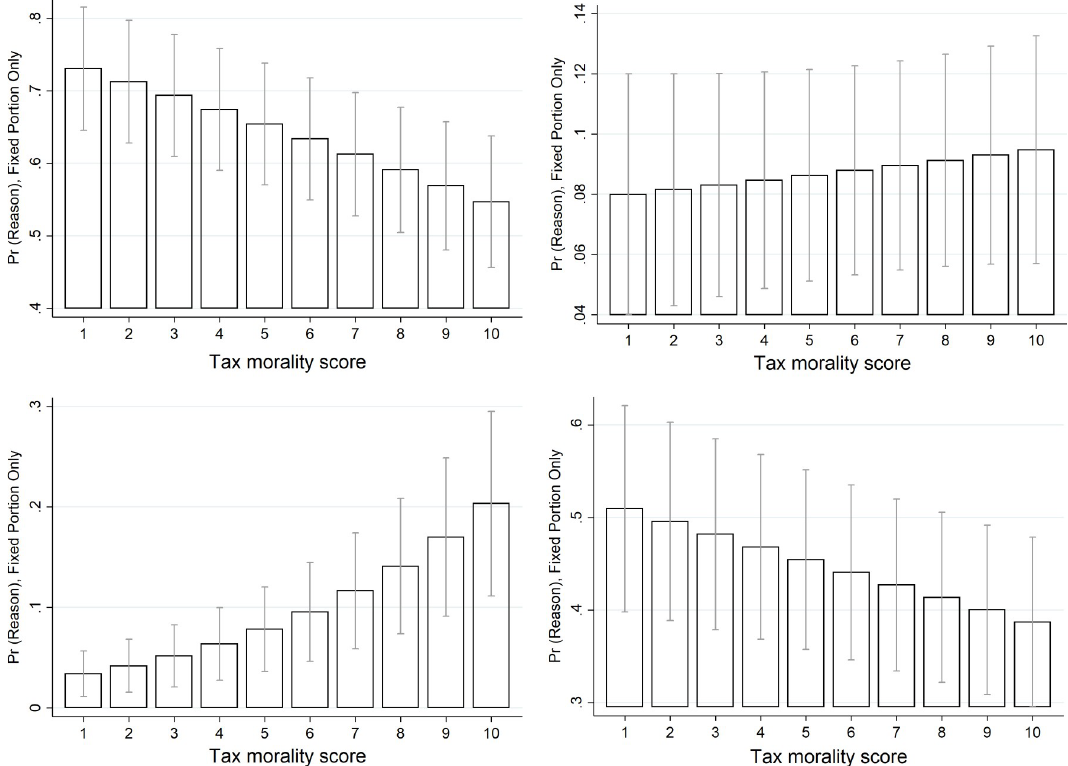
Fig 3. Predicted probabilities of reasons for a ‘representative consumer’ to make purchases from the informal economy: By level of tax morality (with 95% CI). A. More convenient 1) B. Lack of availability on regular market, C. Involuntary, D. Social and/or redistributive reasons. Notes : Higher tax morality score = high tax morality; 1) Lower price and/or faster/better service/product. Source : author‘s calculations based on data from Special Eurobarometer 498 –Wave EB92.1, Undeclared Work in the European Union, Fieldwork—September 2019 / Publication date—February 2020 (European Commission, 2021).